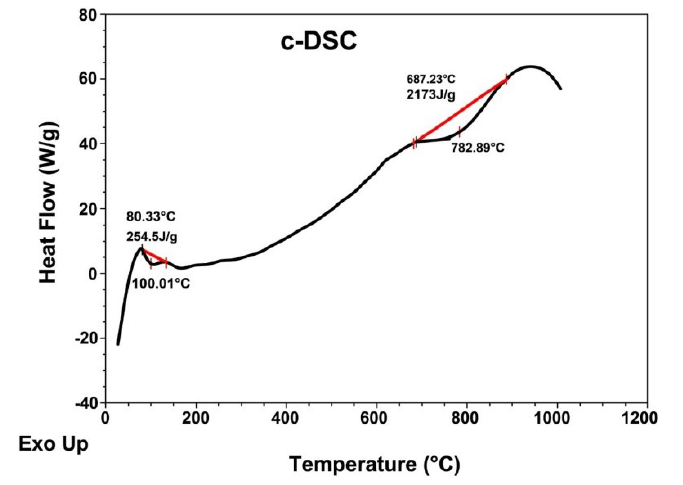
Figure 11. ( a ) TGA, ( b ) DTA and ( c ) DSC thermal analysis thermograms of pyrolytic carbon black recovered from scrap tire.